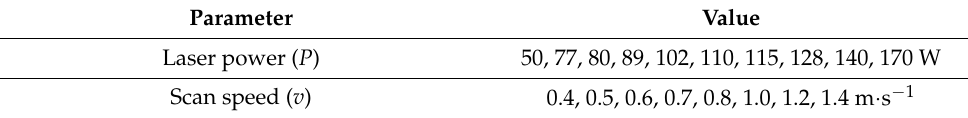
Figure 2. ( a ) The laser powers ( P ) and laser scan speeds ( v ) applied in the present study. ( b – e ) Representative photographs of ( b ) crack-free sample under 128 W–0.4 m · s − 1 , ( c ) cracked sample under 110 W–1.4 m · s − 1 , ( d ) uncondensed sample under 50 W–1.4 m · s − 1 , and ( e ) melt flow sample under 170 W–0.6 m · s − 1 . Table 2. Laser powder and scan speed applied for fabricating Al–15%Fe